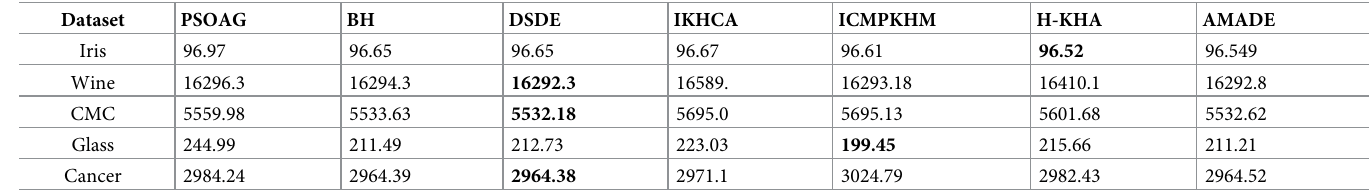
Table 9. Comparison between AMADE and other Algorithms based on the average of the intra-clusters distances.